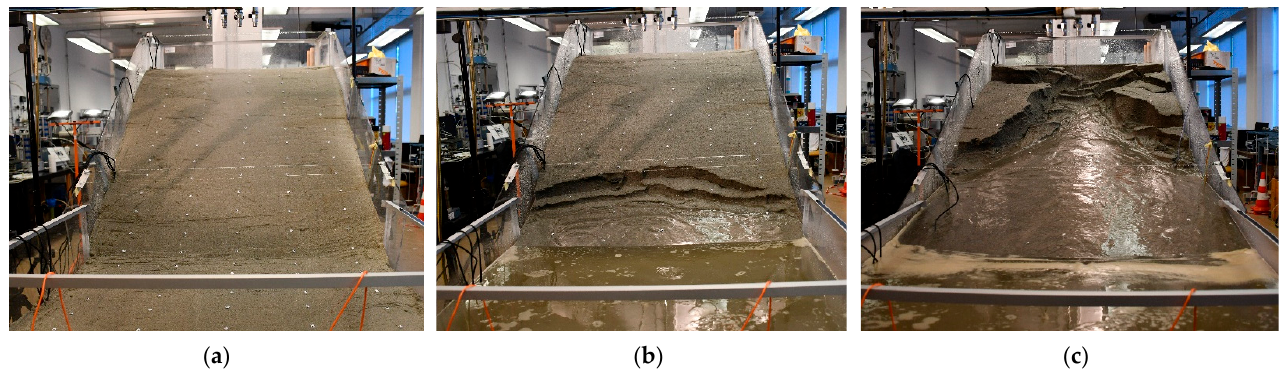
Figure 7. Simulated rainfall in the test considered in Example 1.